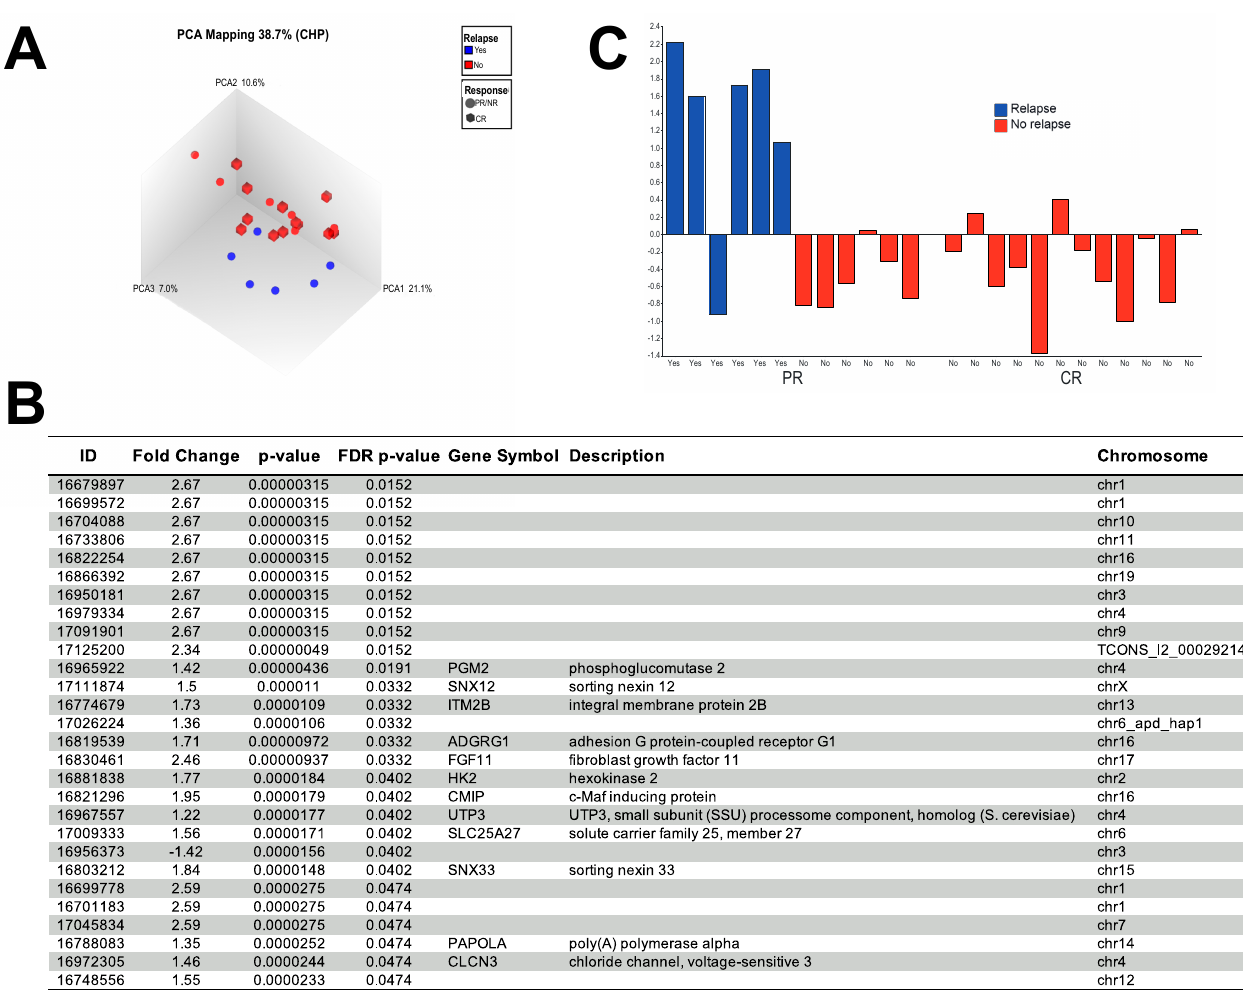
Figure 1. ( A ) Principal component analysis (PCA) plot representing the differentially expressed genes in patients with favourable versus poor survival and complete response versus partial/non- response to treatment. Here, poor survival was defined as a locoregional recurrence within 5 years, and favourable survival was de fi ned as alive and disease free >5-years after diagnosis. Notably, a tendency to separation was observed between patients with (blue) and without (red) relapse in dis- ease. No separation was observed between patients de fi ned as non-/partial responders to treatment (circles) and complete responders (boxes). ( B ) The list of di ff erentially expressed genes (FDR < 0.05) in patients with favourable versus poor survival. ( C ) Bar chart showing the relative tumour FGF11 gene expression as determined by microarray analysis in all 24 patients. Patient bars are arranged according to treatment response and colour coded according to relapse status.